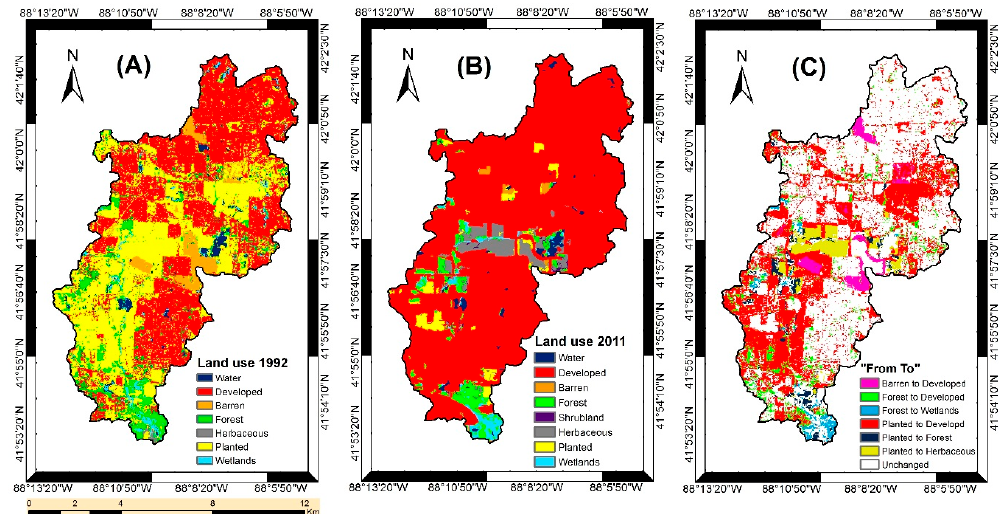
Figure 5. Land use types in the UWBDR watershed in: ( A ) 1992; ( B ) 2011; and ( C ) the transition between 1992 and 2011. Table 6. Transition matrix (in percentages) of land use change in UWBDR from 1992 to 2011. 1992